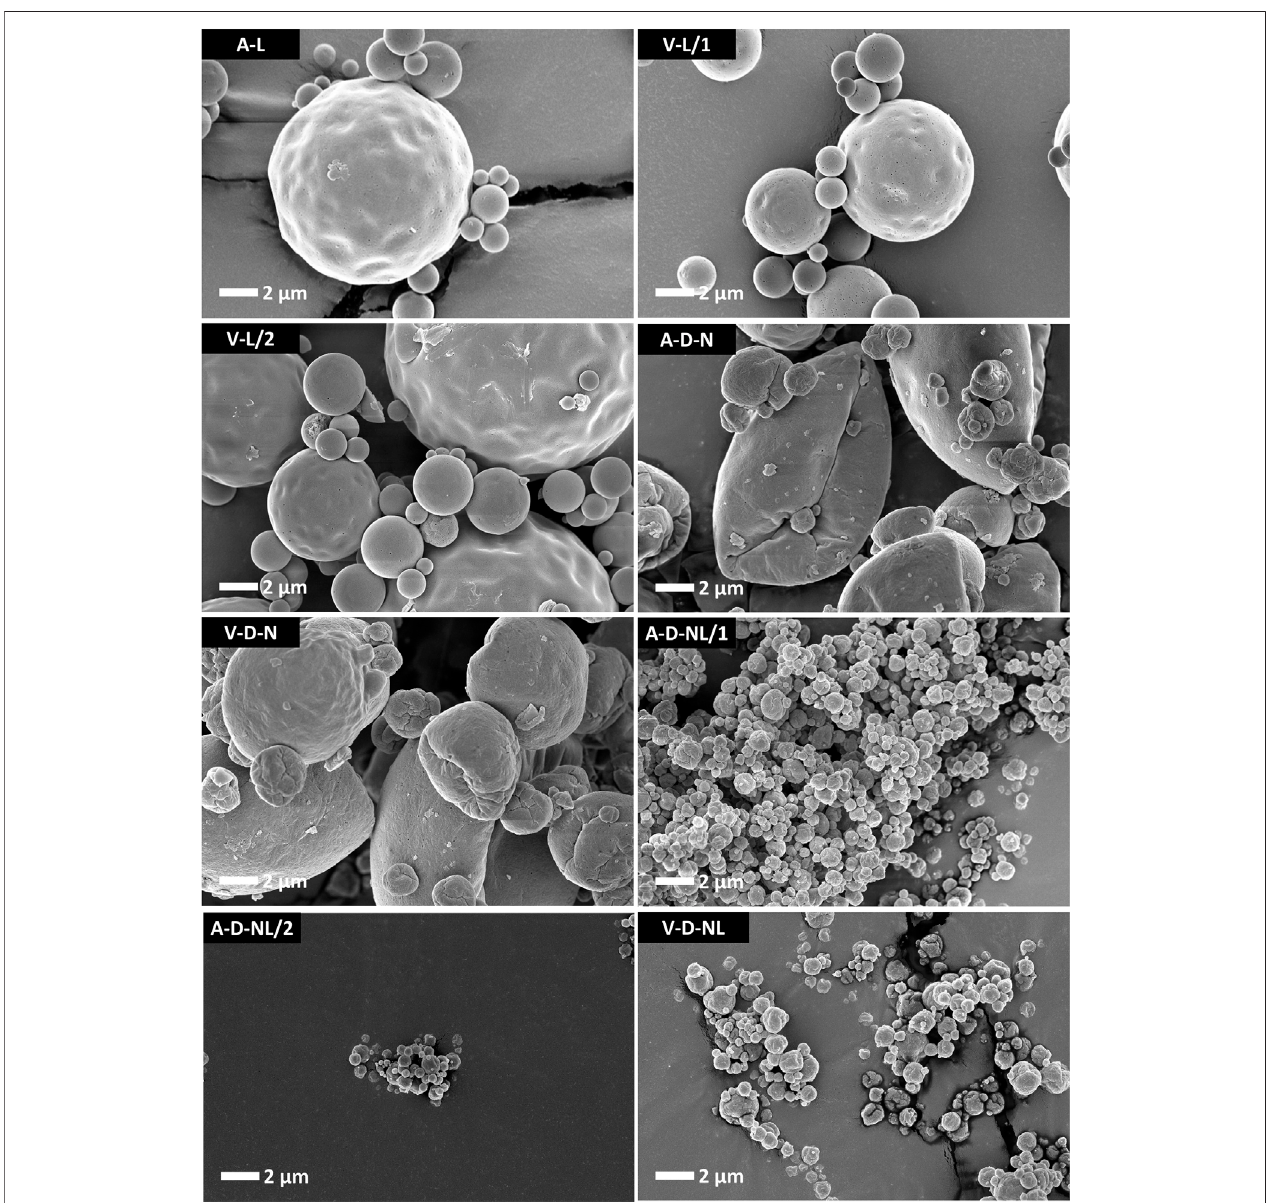
FIGURE 3 | SEM images of the spray-dried powders prepared for the mouse model experiments. The lots containing trileucine that were designed for delivery of dry powder (A-D-N, V-D-N, A-D-NL/1, A-D-NL/2, and V-D-NL) demonstrate a more rugose particle morphology as compared to the lots intended for delivery after reconstitution (A-L, V-L/1, and V-L/2). The lots designed for dry powder deposition in the nose (A-D-N and V-D-N) are signi fi cantly larger than the lots designed for dry powder deposition in the nose and lungs (A-D-NL/1, A-D-NL/2, and V-D-NL). Smaller particles were designed to promote greater airway penetration. Scale bars are based on the respective images. Nomenclature: V – Vaccine; A – Adjuvant; L – Liquid; D – Dry powder; N – Nose; NL – Nose and Lung.